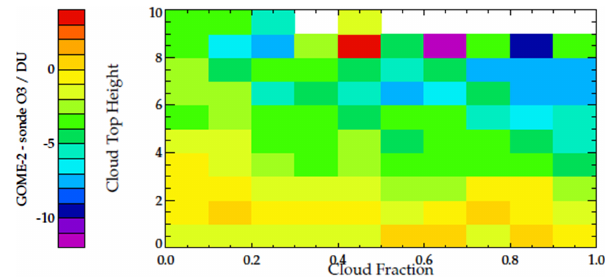
Figure 8. The lowest subcolumn ozone (surface to 450hPa) differ- enced from ozonesonde subcolumn, without AKs applied and with- out any cloud clearing. In the presence of high/thick cloud where fewer photons can penetrate, there is less sensitivity to the lower- most ozone subcolumn.